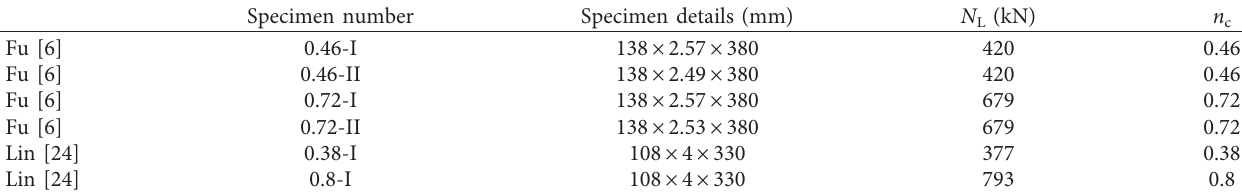
Table 1: Parameters of the CFST specimens.